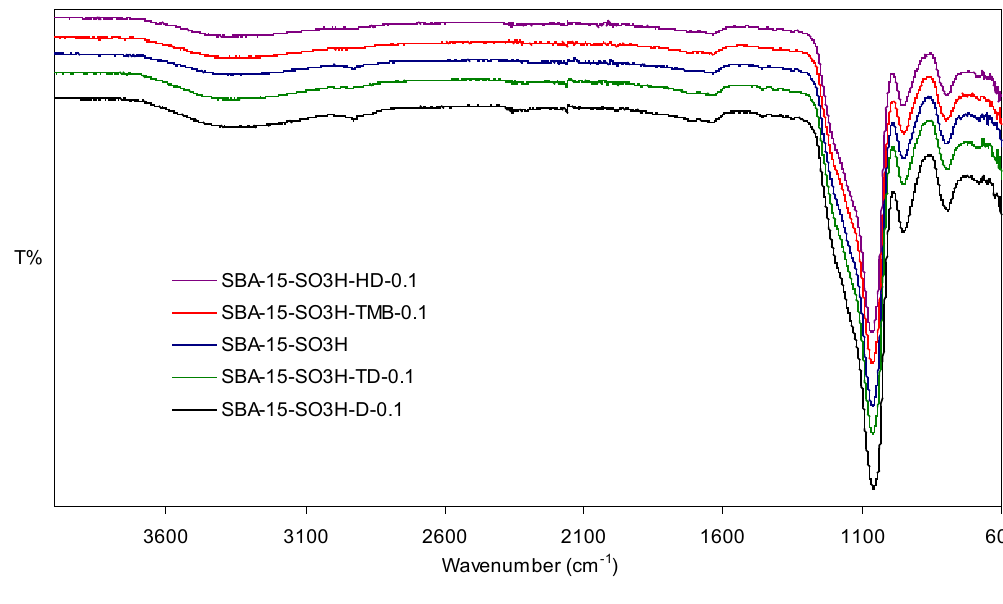
H) and swelled samples. 3